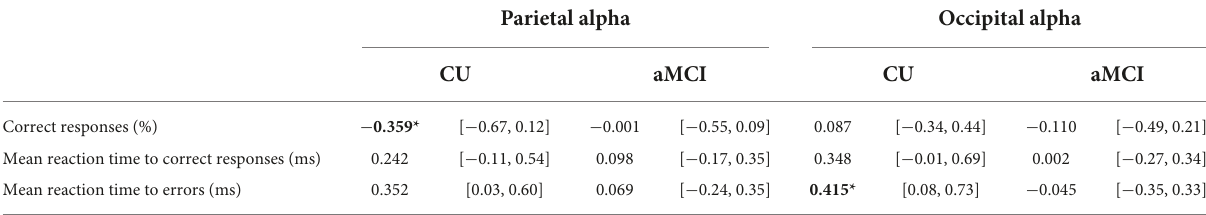
TABLE 6 Correlation coefficients (Pearson’s r ) and correspondent 95% CI between eLORETA source solutions (normalized alpha current source density) of parietal and occipital alpha rsEEG rhythms and working memory task performance for CU and aMCI subjects. Parietal